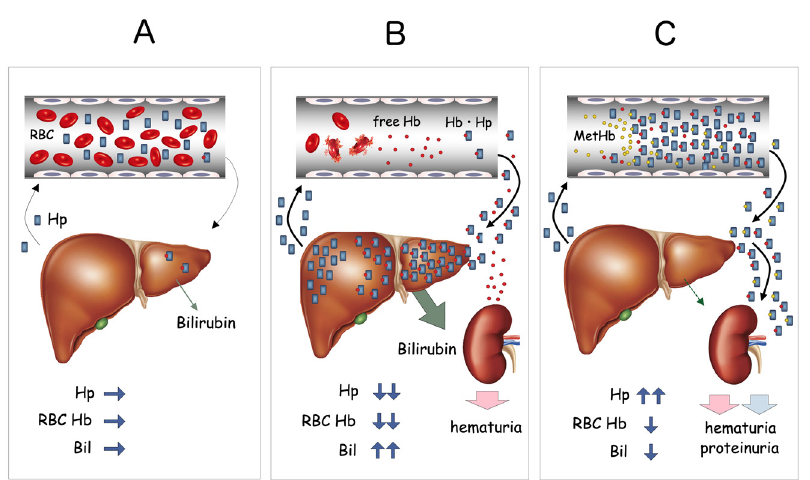
Figure 3. Proposed mechanism of MetHb accumulation in blood. Under normal conditions, small amounts of Hb derived from hemolysis are rapidly bound by circulating Hp, forming Hb-Hp complexes, which are rapidly taken up by the liver through CD163 ( A ). When massive hemolysis occurs, as in the case of hemolytic anemia, large amounts of free Hb are bound by serum Hp and transferred to the liver ( B ). This results in a significant reduction of serum Hp and increased indirect bilirubin (Bil) derived from the heme degradation pathway. In HO-1-deficient patients, both OxyHb and MetHb bound to Hp accumulate within the serum. Despite the apparent intravascular hemolysis, total Hp content is significantly increased, serum bilirubin level remains low, and overflow of Hb-Hp complex into the urine is seen ( C ).